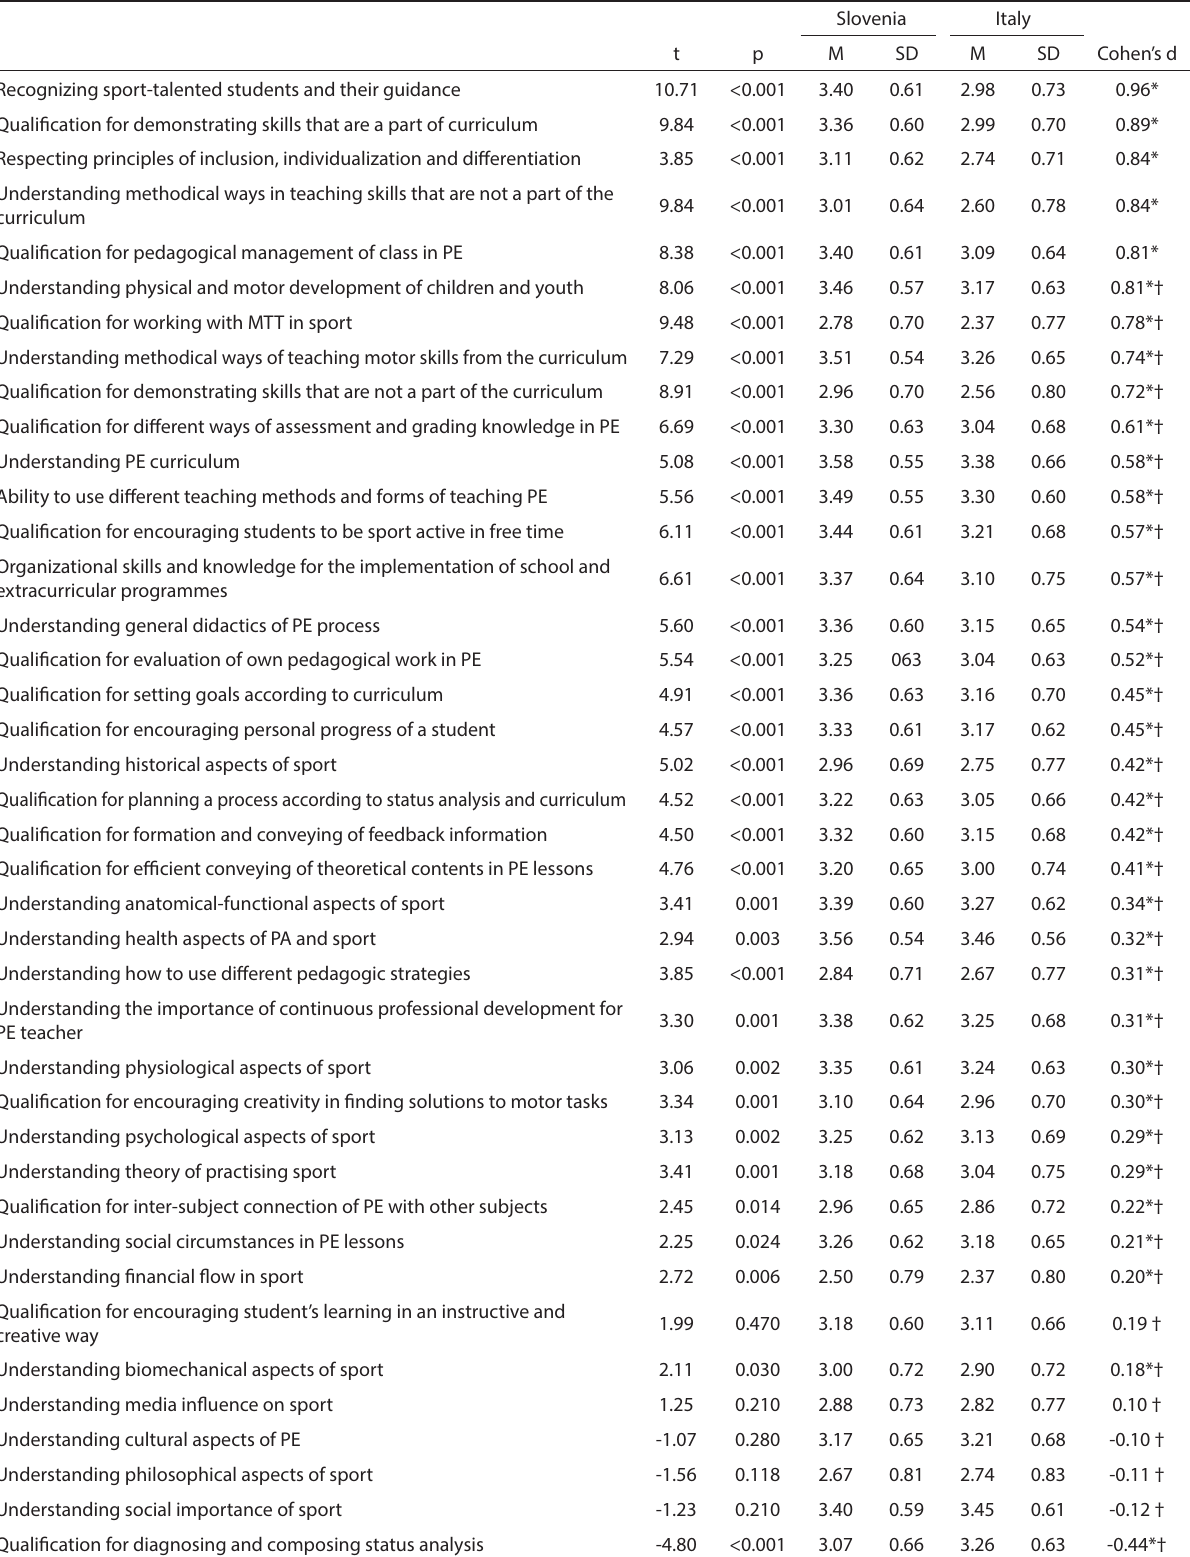
Table 1. Descriptive statistics of professional competences items sorted by Cohen’s d index